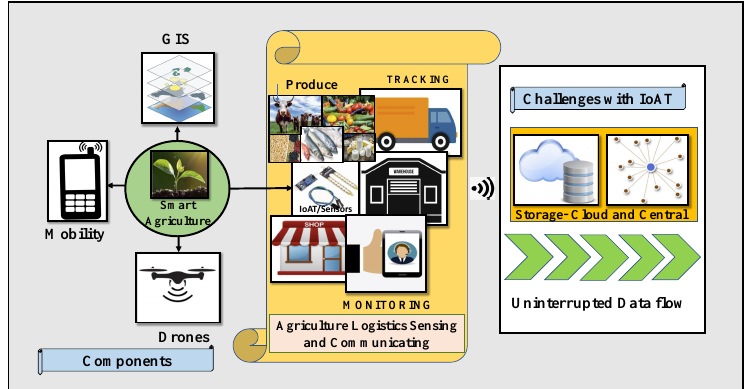
Figure 2. Components of smart agriculture and challenges of the